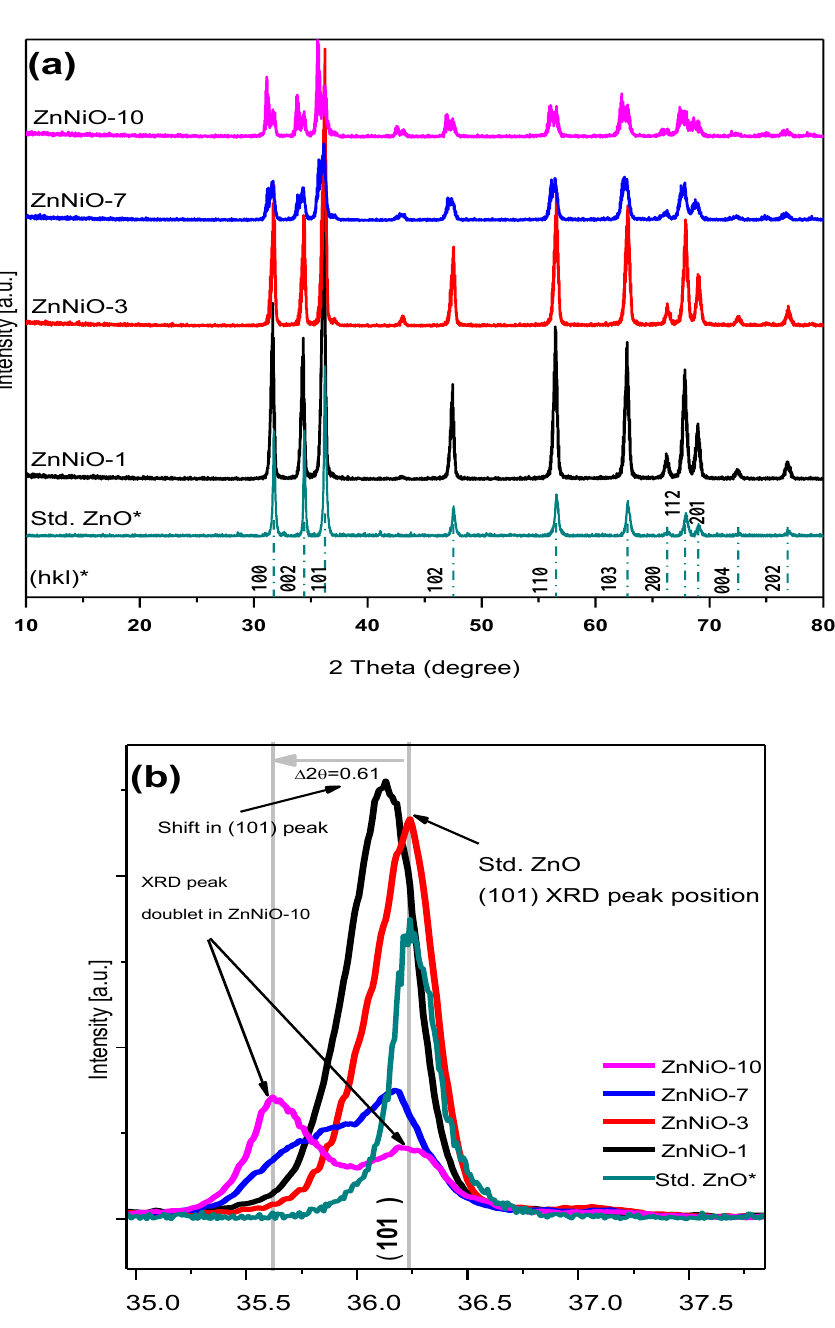
Figure 1. ( a ) XRD patterns of ZnNiO nanoparticles are presented in vertically aligned mode in increasing doping percentages. The Ni doping increases in samples ZnNiO-1, -3, -7 and -10. Asterix sign (*) shows the standard ZnO’s XRD pattern and its (hkl) reflection positions as adopted from the XRD card, RRUFFID-R050492. Figure ( b ) shows (101) -peak profiles of most intense XRD reflection in ZnNiO indicating a 2θ shift upon doping and a gradual development of 101-doublet peaks. XRD patterns of ZnNiO powders are shown in Figure 1a. For the sake of clarity, a vertical offset of XRD patterns with Ni doping is shown in the figure. All samples exhibit characteristic ZnO peaks at (100), (200) and (101) XRD reflections confirming the wurtzite structure of ZnNiO. Additionally, the sharper and more intense nature of XRD peaks at lower Ni concentrations indicates a strong